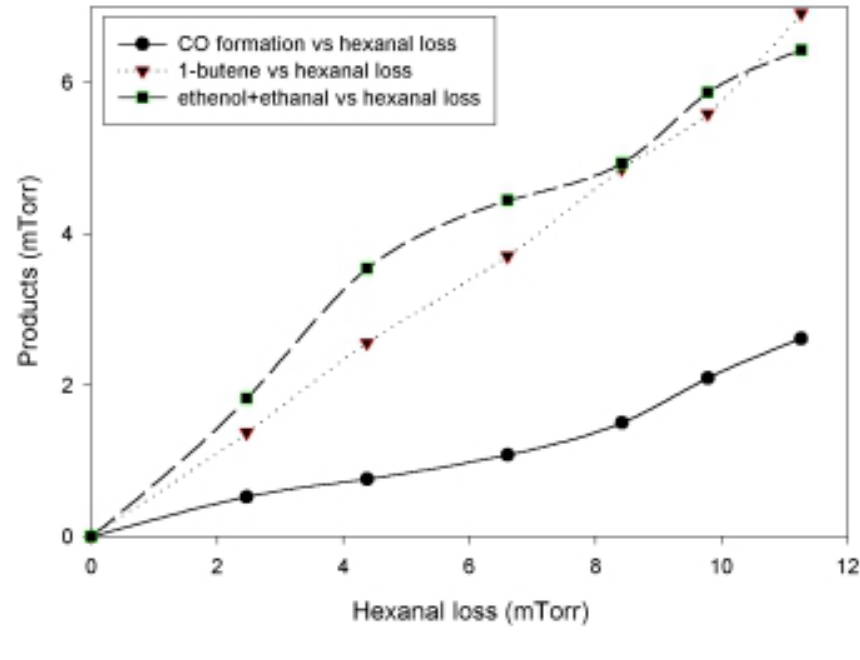
Figure 3. Photolysis of n -hexanal - products formation versus loss in n -hexanal. See comments on Figure